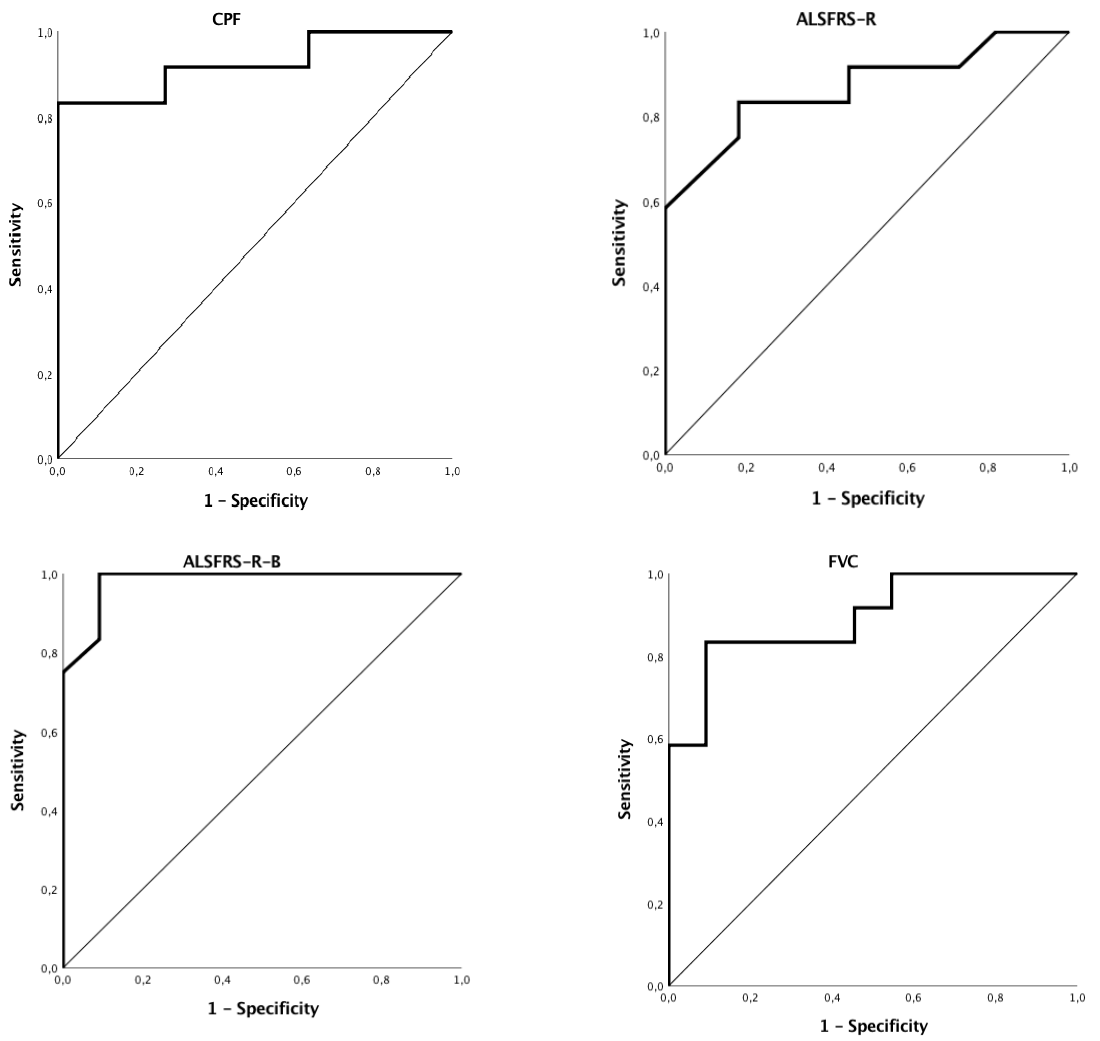
Figure 3. Receiver operator curves (ROC) for functional and endoscopic measures that were considered significant to percutaneous endoscopic gastrostomy (PEG) indication. ALSFRS-R, ALS Functional Rating Scale-Revised; ALSFRS-R-B, ALS Functional Rating Scale-Revised bulbar sub-score; CPF, cough peak flow; FVC, forced vital capacity.